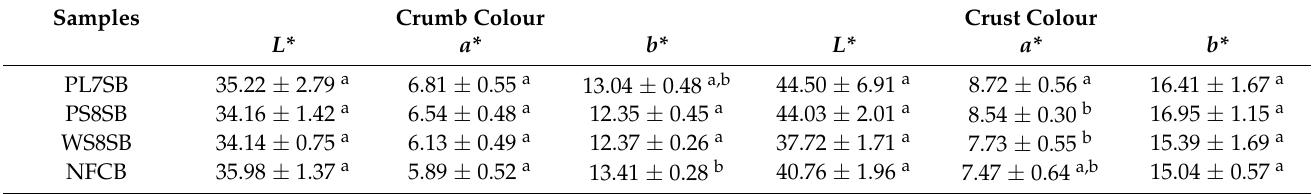
Results indicate mean values ± SD. Data within a row followed by the same letter in superscript are not significantly different ( p value < 0.05) according to Tukey’s